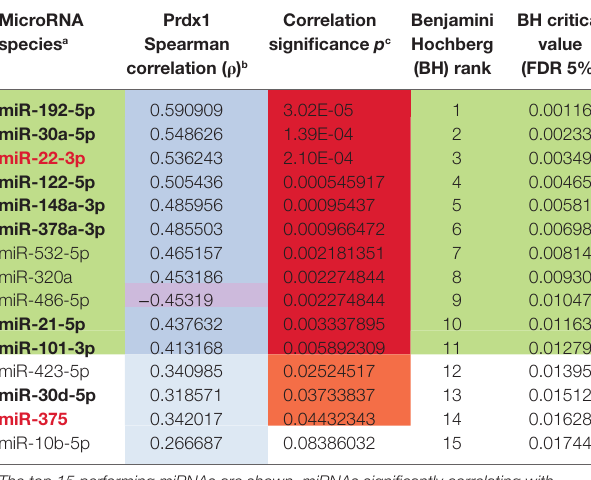
TaBle 2 | Correlations of circulating inflammatory-relevant microRNAs (CIR-miRNAs) with severity of sepsis as detected by sequential organ failure assessment (SOFA).